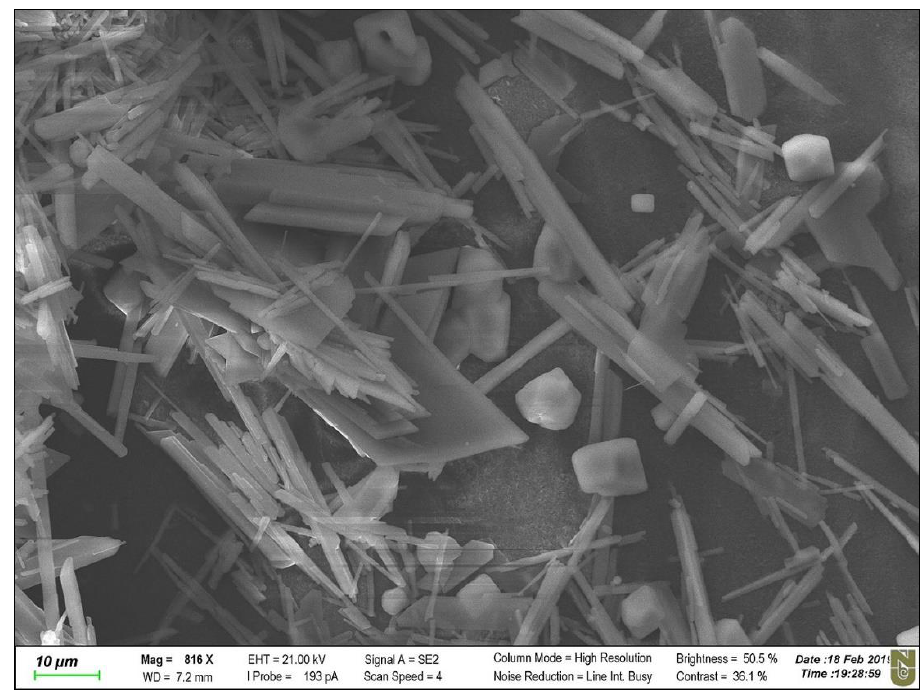
Figure 9. SEM image of the aquaporin FO membrane’s active layer after the s caling experiment. Scaling conditions: concentrations of NaCl, CaCl 2 , and Na 2 SO 4 are 1.754, 6.132, and 4.487 g/L, respectively; SI = 2.45; 12.5 cm/s cross-flow velocity; the feed and draw solutions were circulated counter-currently; and an AL-FS orientation.